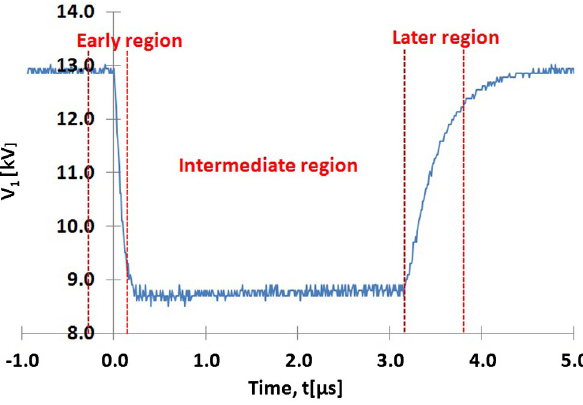
FIG. 37. Profile of the voltage applied to the middle electrode of the Einzel lens.